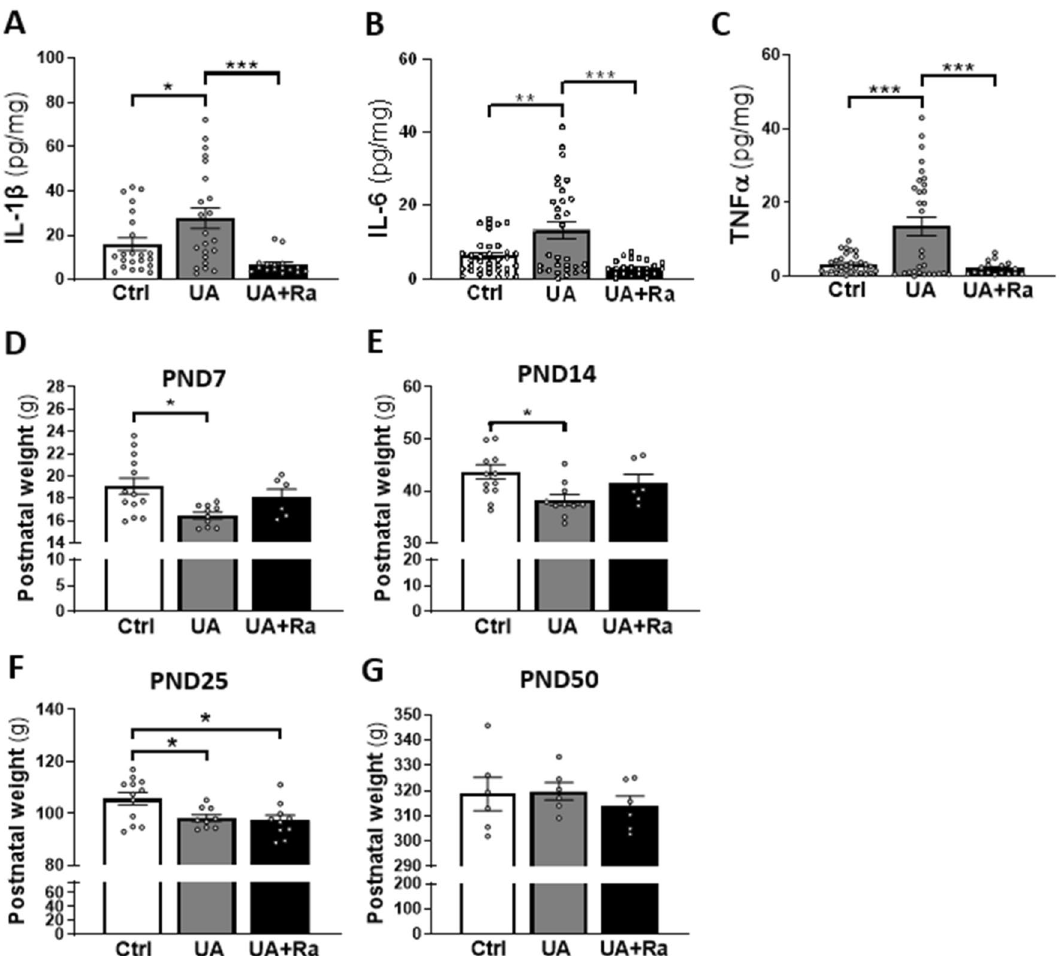
Figure 1. Placental inflammation and growth restriction induced by uric acid exposure during pregnancy. Sterile inflammation exposure led to increased placental inflammation and anti-inflammatory intervention decreased levels of IL-1β ( A ), IL-6 ( B ) and TNF-α ( C ) proteins at birth. N = 6–12 dams (i.e. Ctrl = 12; UA = 12; UA + Ra = 6), 3 placentas/dams. Quantification of postnatal weight at PND7 ( D ), PND14 ( E ), PND25 ( F ) and PND50 ( G ) after exposure to sterile inflammation. Treatment with UA led to decreased weight maintained in the early postnatal period. N = 6–10 litters (i.e. PBS = 8; IL-1Ra = 6; UA = 10; UA + Ra = 6) at PND7, 14 and 21 and N = 6 litters in each groups at PND50. *p < 0.05; **p < 0.01; ***p < 0.001; Results presented as mean ± SEM. Statistical analysis by one-way ANOVA and Tukey’s multiple comparisons test with with GraphPad Prism 9.2.0 (GraphPad Software, CA); www. graph pad.